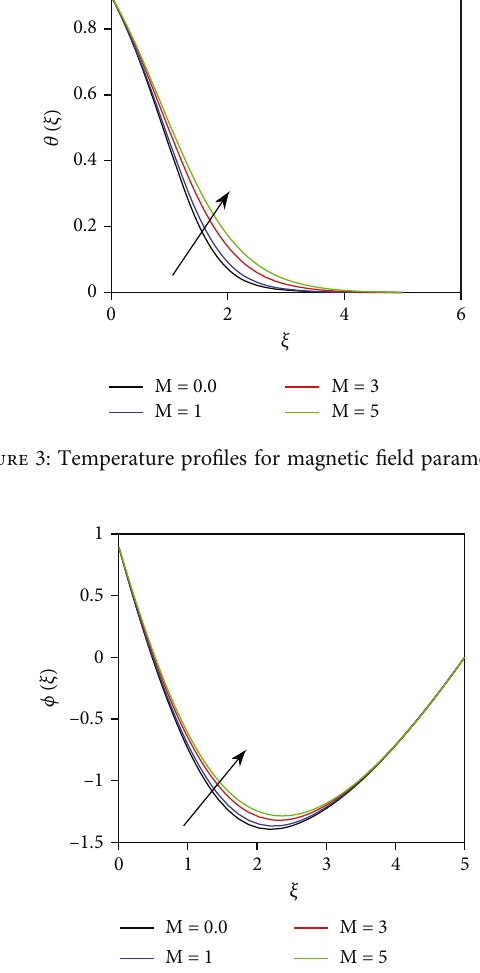
Figure 4: Concentration pro fi les for magnetic fi eld parameter M .